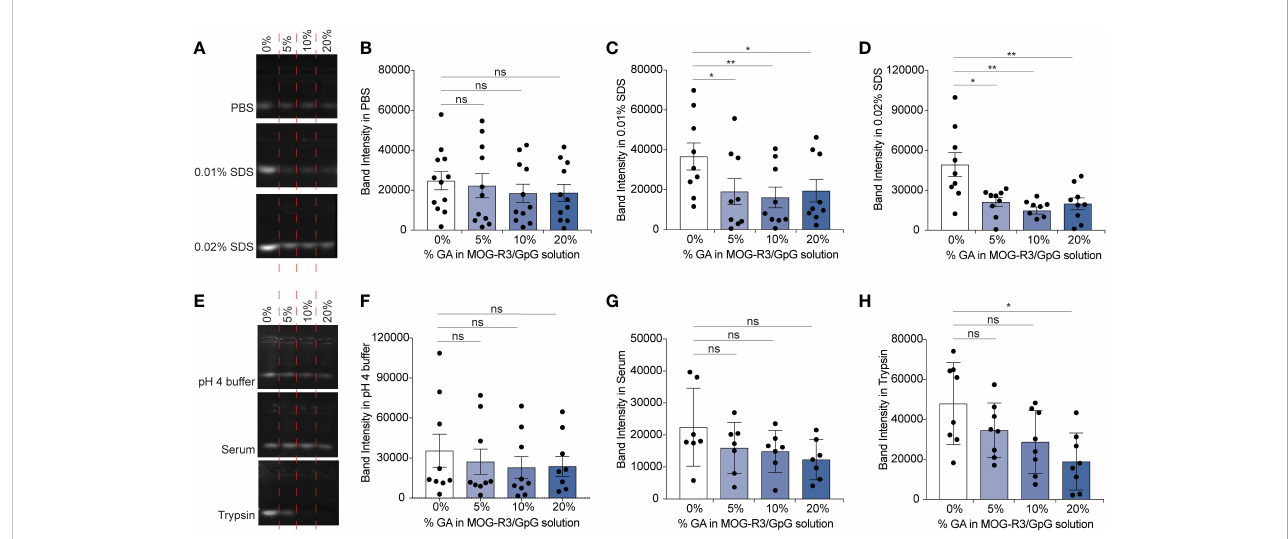
FIGURE 3 GpG in iPEM capsules is maintained in capsular form when cross-linked and incubated in various conditions. (A) Representative agarose gel of non- cross-linked and cross-linked MOG-R3/GpG iPEMs incubated in PBS, 0.01% SDS, 0.02% SDS and (B – D) quanti fi cation of the band intensities observed for each condition. (E) Agarose gel of non-cross-linked and cross-linked MOG-R3/GpG iPEMs incubated in pH 3-4 buffer, fetal bovine serum, and Trypsin and (F – H) quanti fi cation of the band intensities observed for each condition. Data represents mean ± standard error mean from multiple iPEM batches (N = 8-12). Statistical analysis performed using one-way ANOVA followed by Dunnett ’ s multiple comparisons between 0% iPEMs and cross- linked iPEMs. *p < 0.05, **p < 0.01, ns, not signi fi